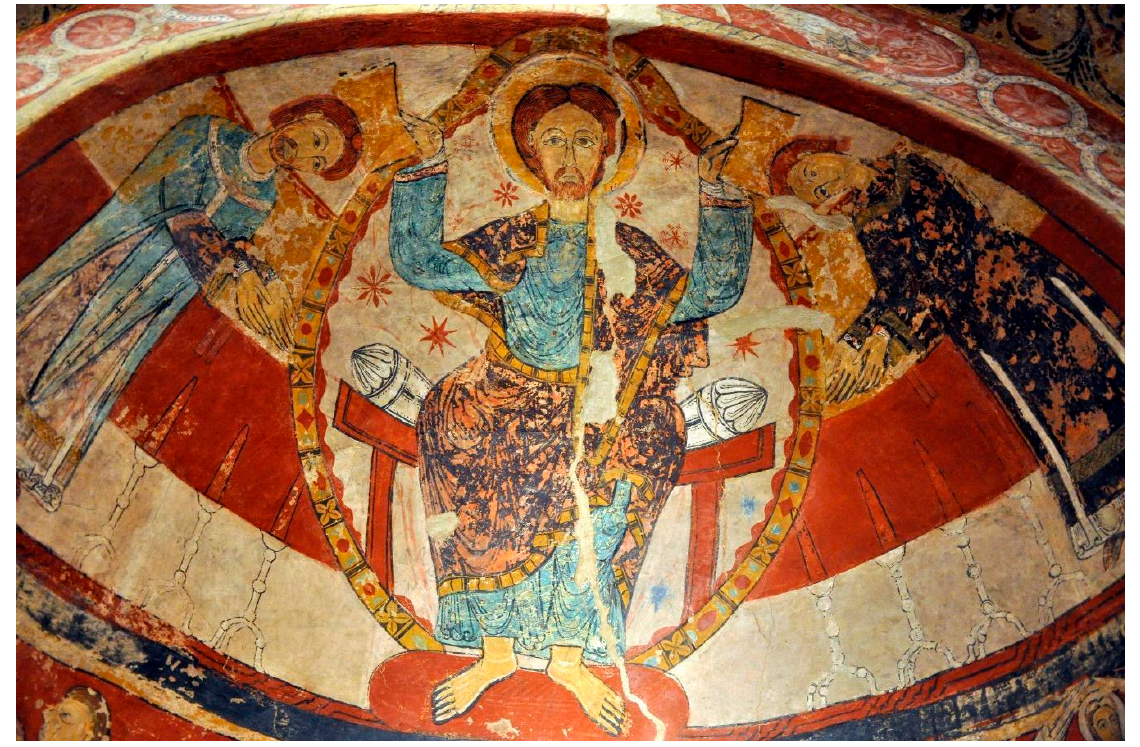
Figure 4. Wall paintings at Santa Maria de Terrassa: the chapel’s half-dome. © Photo: Carles Sánchez.